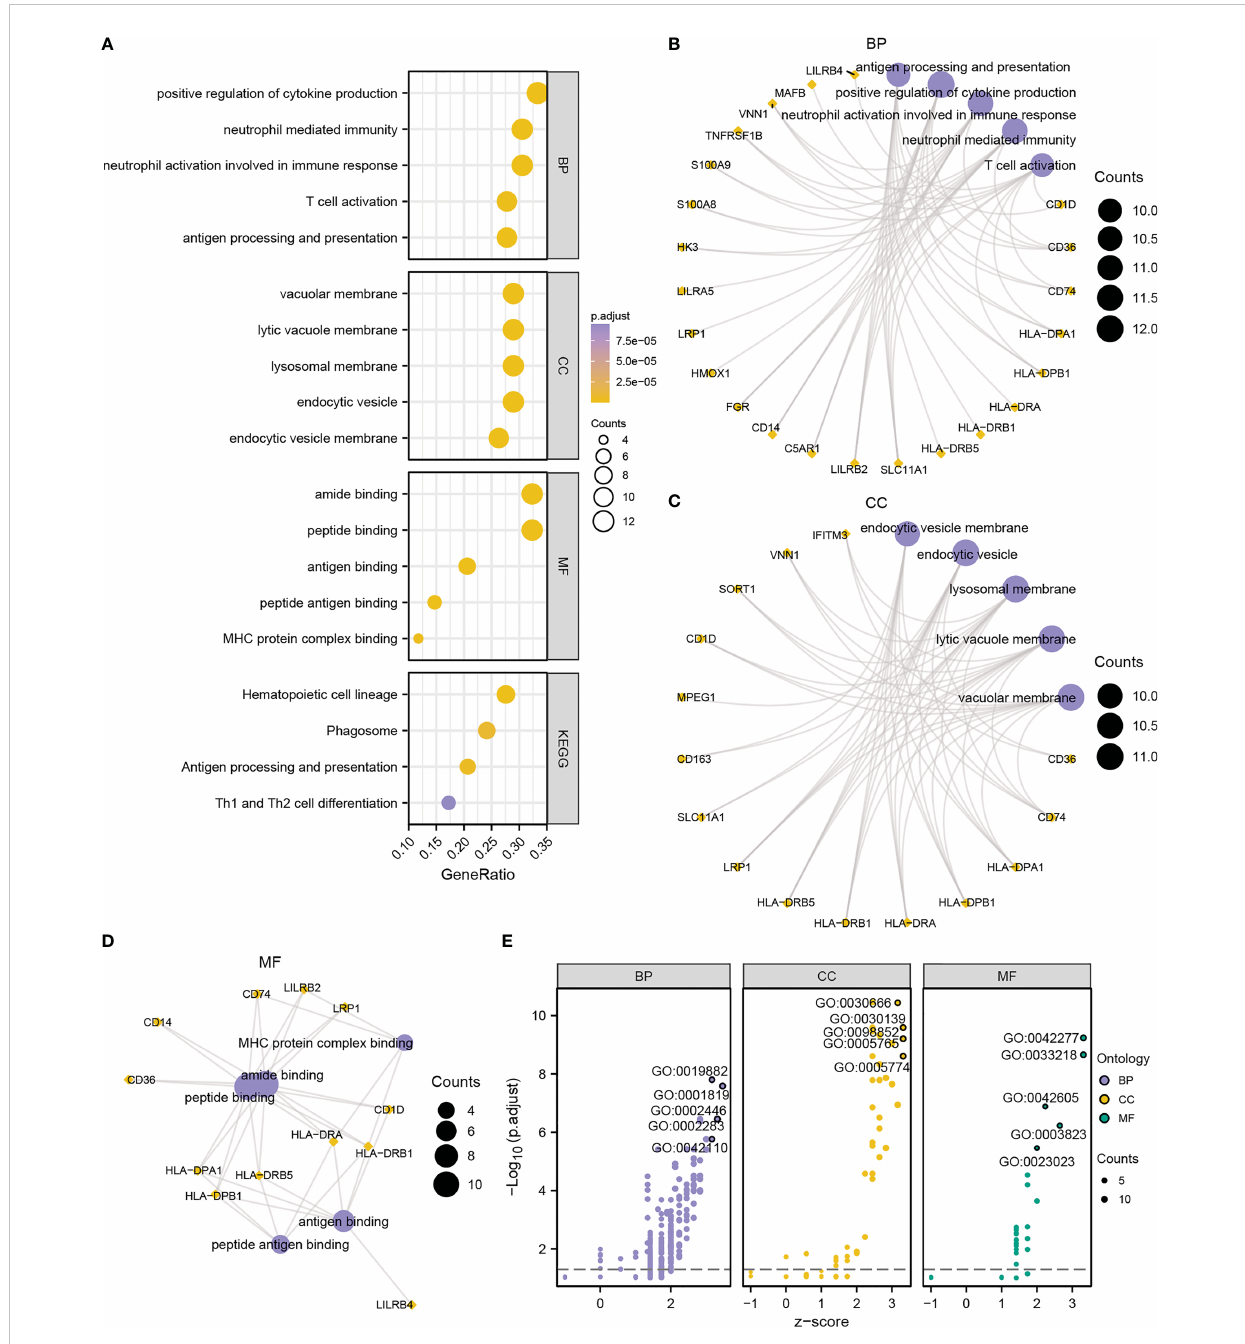
FIGURE 8 Functional annotation of DEGs between high- and low-risk groups. (A) Bubble chart showing the GO or KEGG analysis results. B-D. GO analysis for DEGs in BP (B) , CC (C) , and MF (D) terms. (E) Bubble chart displaying the GO analysis results of DEGs combined with logFC. The ordinate in the bubble chart (A) is the GO terms, and the length of the bubble from Y-axis stands for the GeneRatio value of GO terms. In network diagrams (B – D) , the orange dots represent speci fi c genes, and the lavender circles represent speci fi c pathways. In the bubble chart (E) , the lilac circles represent the BP pathway; the orange circles represent the CC pathway; and the green circles represent the MF